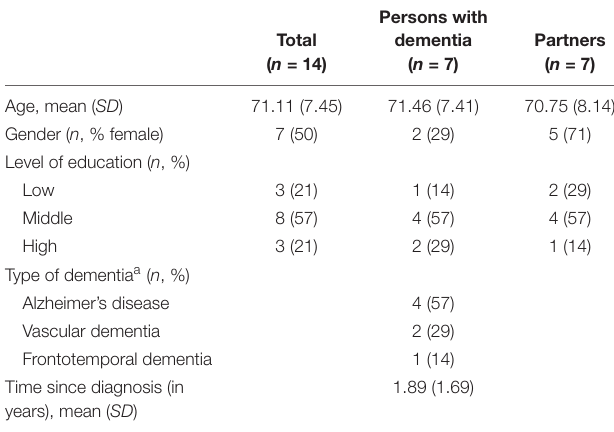
TABLE 3 | Characteristics of people with dementia and partners at